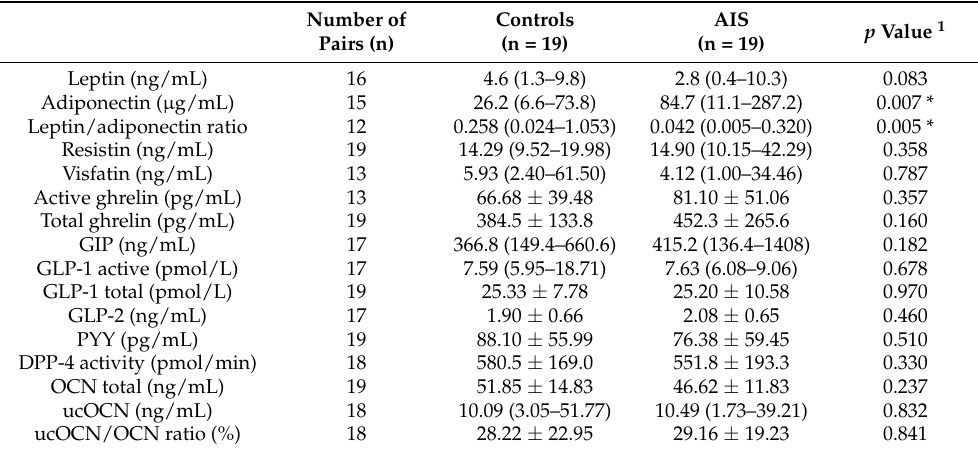
Table 5. Fasting levels of metabolic parameters in control and AIS